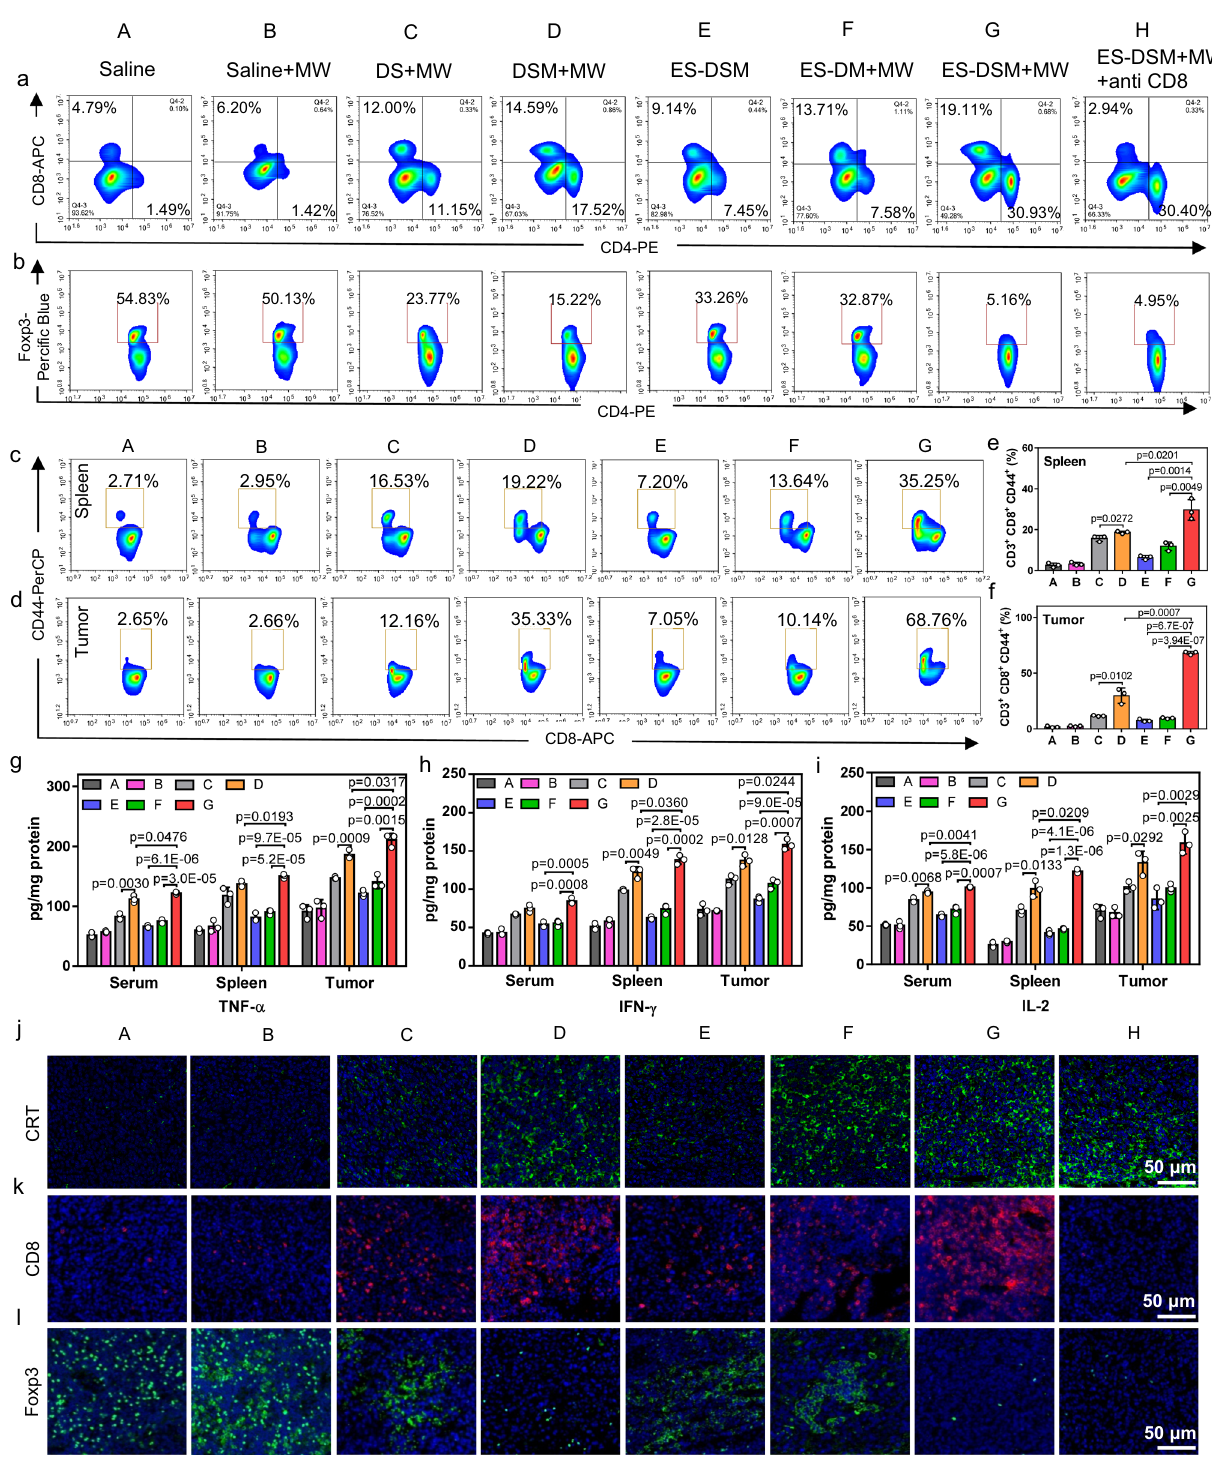
Fig. 7 Evaluation of the immune response after different treatments in 4T1 tumor models. The ratios of a CD3 + CD4 + and CD3 + CD8 + T cells in tumors, b CD4 + Foxp3 + T cells in tumors, c CD8 + CD44 + T cells in spleens, and d CD8 + CD44 + T cells in tumors were analyzed by fl ow cytometry at the end of the observation period. Percentages of CD8 + CD44 + T cells in e spleens and f tumors were calculated based on ( c ) and ( d ), respectively ( n = 3). Antitumor cytokine levels, including g TNF- α , h IFN- γ , and i IL-2, in the serum, spleen, and tumor of mice from each group were determined by ELISA assay ( n = 3). Immuno fl uorescence was used to examine the levels of j CRT, k CD8 + T cells, and l Foxp3 + T cells in tumor sections at the end of the observation period. DS: free DOX and SCH; DSM: DOX and SCH co-loaded micelles; ES-DSM: E-selectin-modi fi ed co-loaded micelles; ES-DM: E-selectin-modi fi ed DOX-loaded micelles; MW: microwave radiation (8 W, 30 min). Data are presented as mean values ± SEM and unpaired two-tailed T test was performed in ( e – i ). The experiments in ( j ), ( k ), and ( l ) showed similar results in three independent mice. Source data are provided as a Source data fi